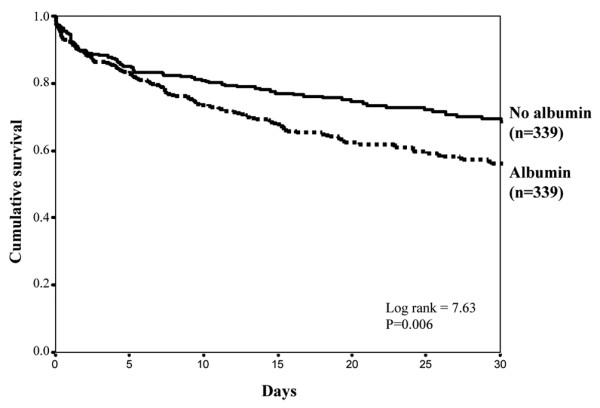
Kaplan-Meier survival curves in patients who received albumin (lower curve) and their propensity matched pairs without albumin administration.